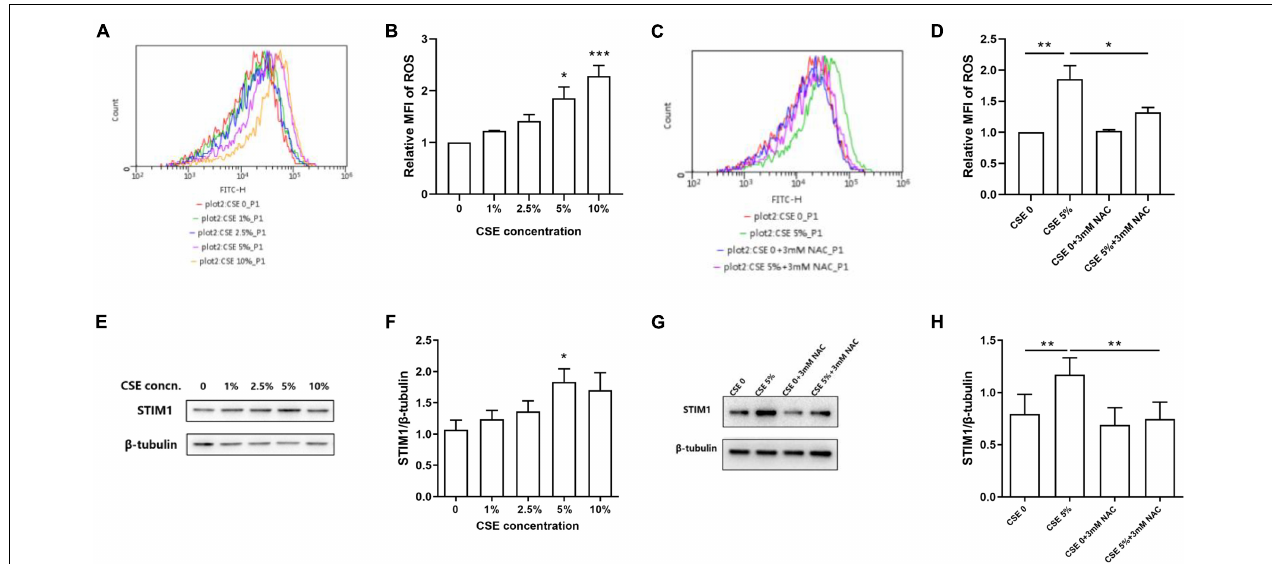
FIGURE 3 | N-acetylcysteine (NAC) alleviates cigarette smoke extract (CSE)-induced ROS production and STIM1 expression in PMA-differentiated THP-1 cells. The representative images of flow cytometry for intracellular ROS levels are shown (A,C) and quantified using FlowJo (B,D) . The intracellular level of ROS was up-regulated as CSE concentration increased in PMA-differentiated THP-1 cells. Pretreatment with 3 mM NAC for 1 h alleviated CSE-induced ROS increase in PMA-differentiated THP-1 cells. The representative images of western blot of STIM1 expression are shown (E,G) and quantified using ImageJ (F,H) . 5%CSE stimulation for 48 h enhanced STIM1 expression in PMA-differentiated THP-1 cells. Pretreatment with 3 mM NAC for 1 h alleviated CSE-induced STIM1 increase in PMA-differentiated THP-1 cells. Data are displayed as mean ± SEM of at least three independent experiments. P -values were calculated using one-way ANOVA followed by Newman–Keuls test. * P < 0.05, ** P < 0.01, and *** P < 0.001 represent significant differences. MFI, Mean fluorescent intensity; ROS, reactive oxygen species; CSE, cigarette smoke extract; NAC, N-acetylcysteine; STIM1, stromal interaction molecule 1; and PMA, phorbol myristate acetate.